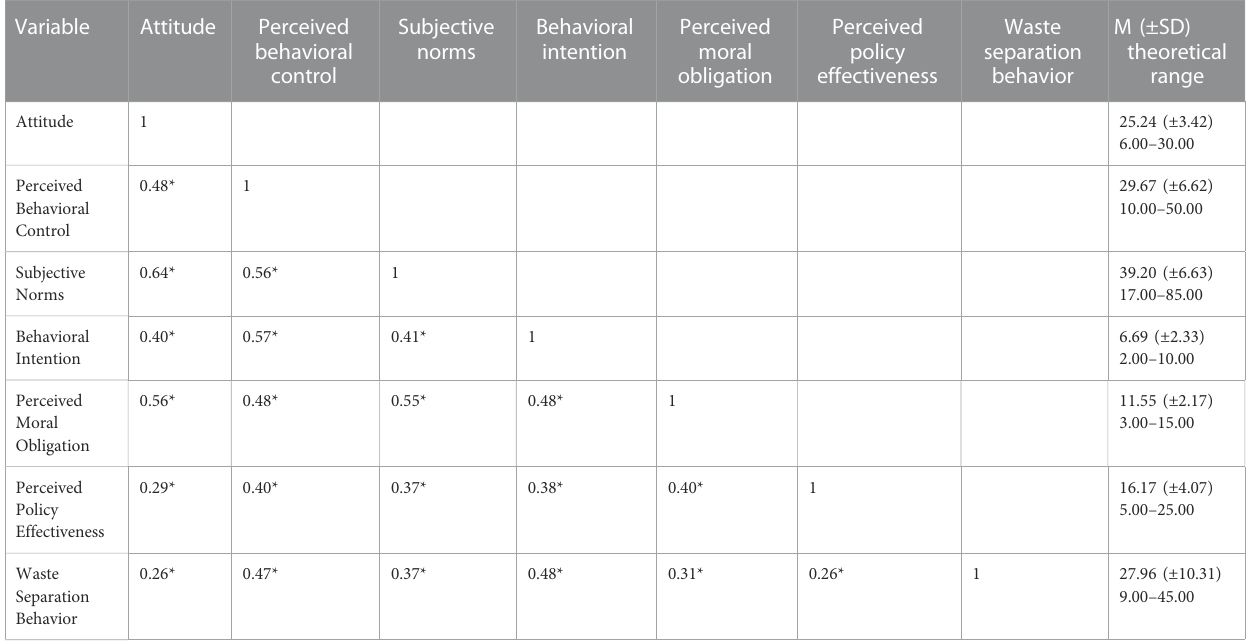
TABLE 3 Correlation matrix for all study